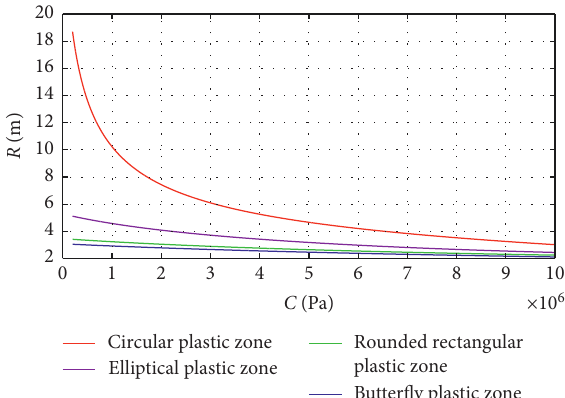
Figure 9: Change of radius of plastic zone with respect to